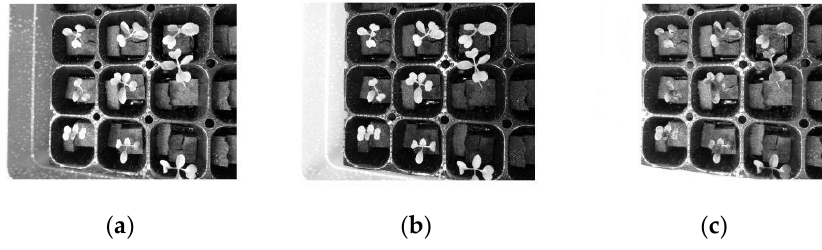
Figure 15. R, G, and B image: ( a ) R-image; ( b ) G-image; ( c ) B-image.